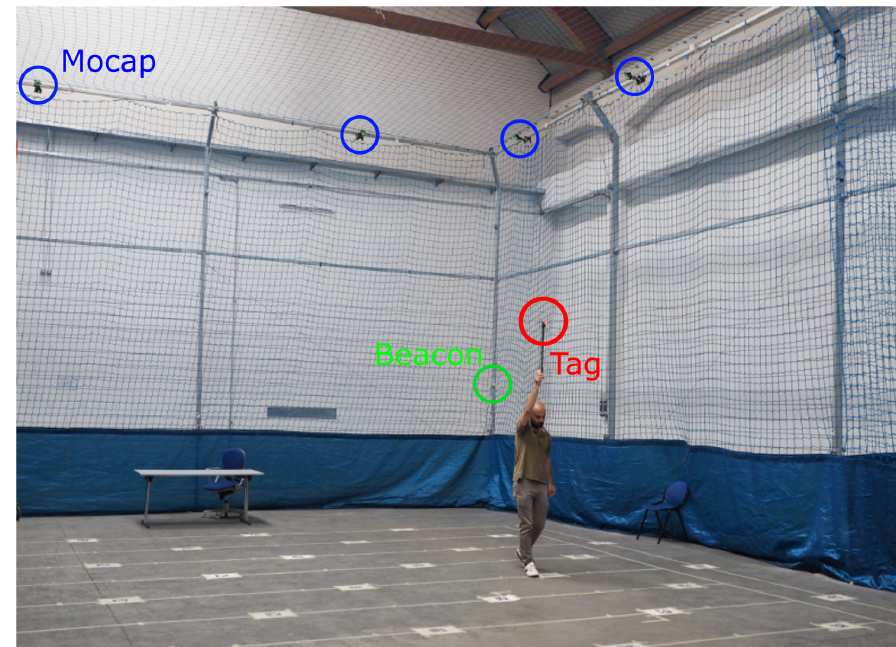
Figure 4. The experimental setup exploited for data collection. In the picture are visible: in red, the moveable tag on the top of the stick while being moved by hand inside the operative space, in blue, the motion capture system (Mocap) used to measure the reference position of the tag, and in greed, one of the eight